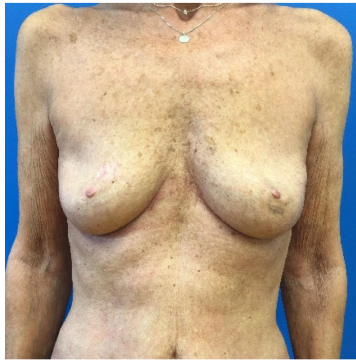
Figure 2. A 65-year-old patient presented to our department with the diagnosis of a multifocal invasive mamma carcinoma involving the nipple-areola complex. An interdisciplinary tumor-board decision was made to perform a subcutaneous mastectomy, including the nipple-areola complex and sentinel lymph node biopsy, plus immediate breast reconstruction with a TMG flap from the contralateral side.